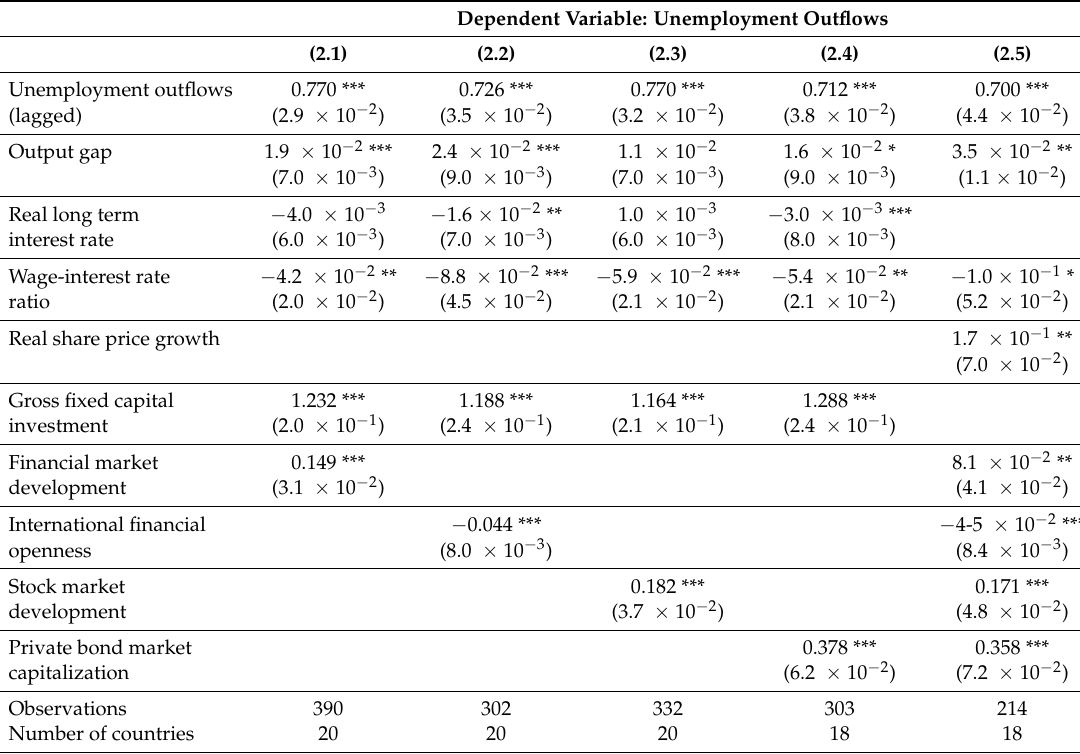
Table 2. Financial market determinants of unemployment